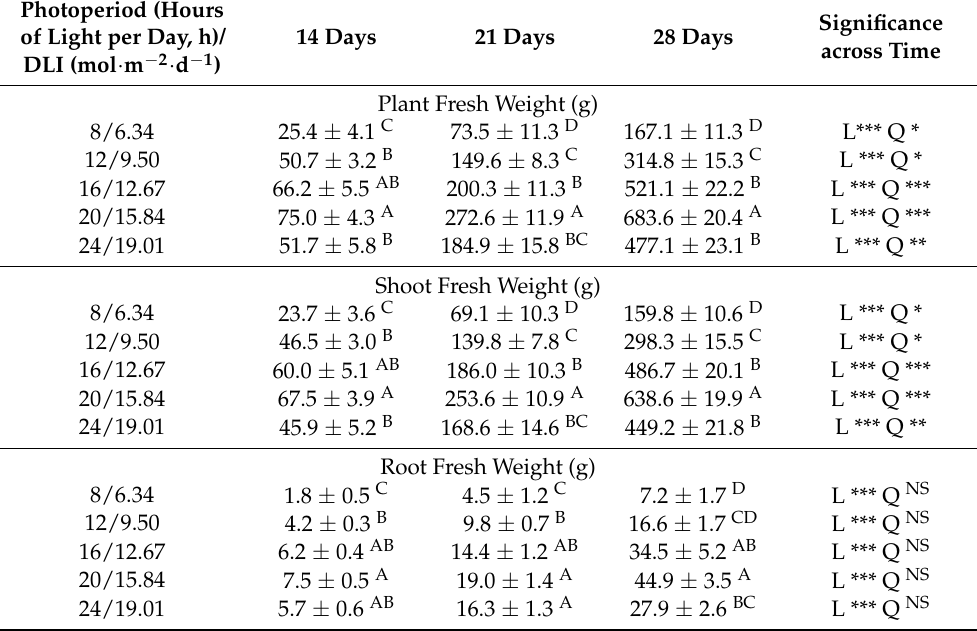
Letters represent mean separation comparison across light treatments within the same harvest day using Tukey’s HSD (alpha = 0.05). Significance of linear (L) or quadratic (Q) regression of a given treatment over treatment time: NS, *, **, *** denotes nonsignificant or significant at p ≤ 0.05, 0.01, or 0.001,